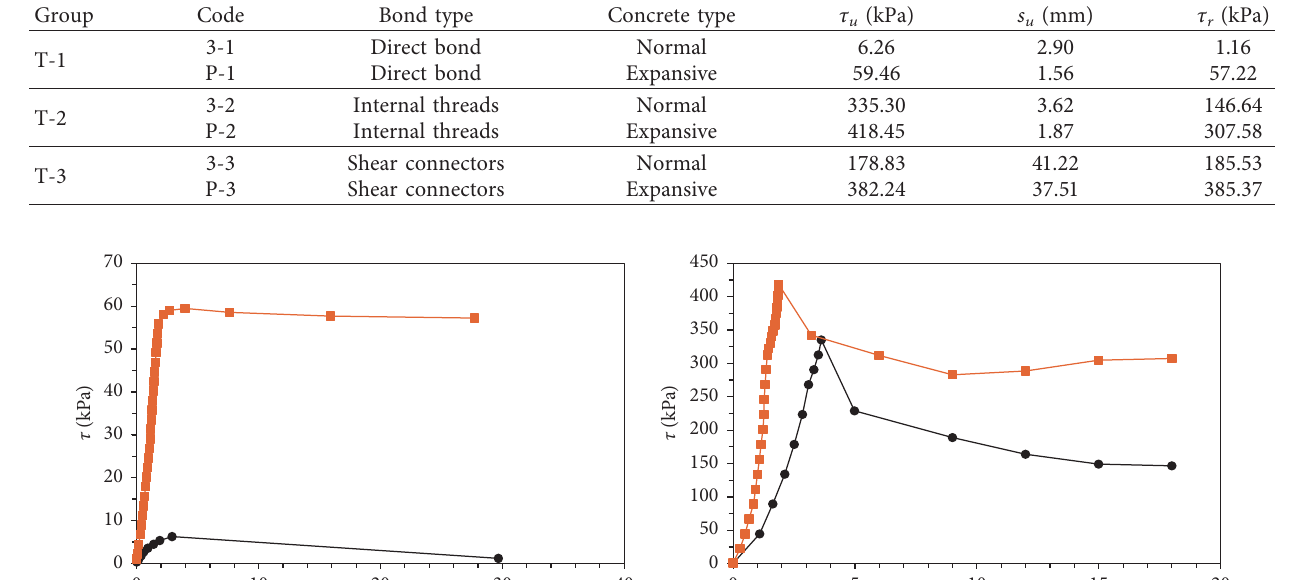
Table 10: Test results of the specimens in Groups T-1, T-2, and T-3. Group